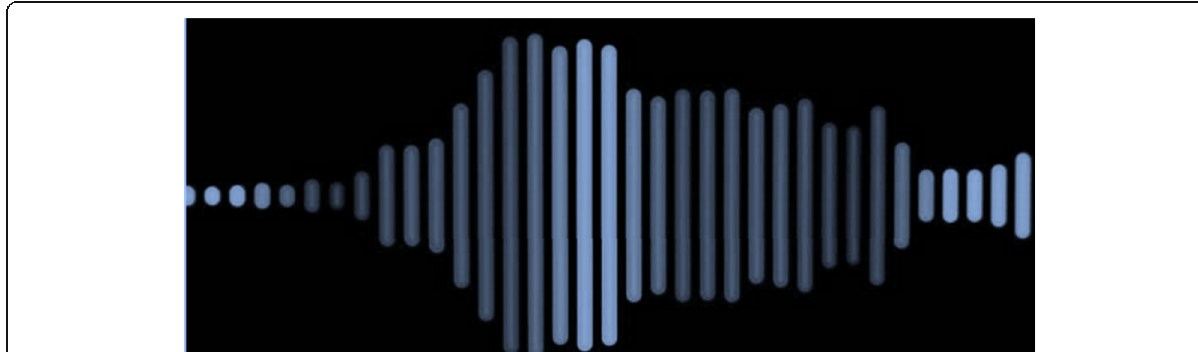
Fig. 10 The b sound image of small group that Horne uses [i] vowel